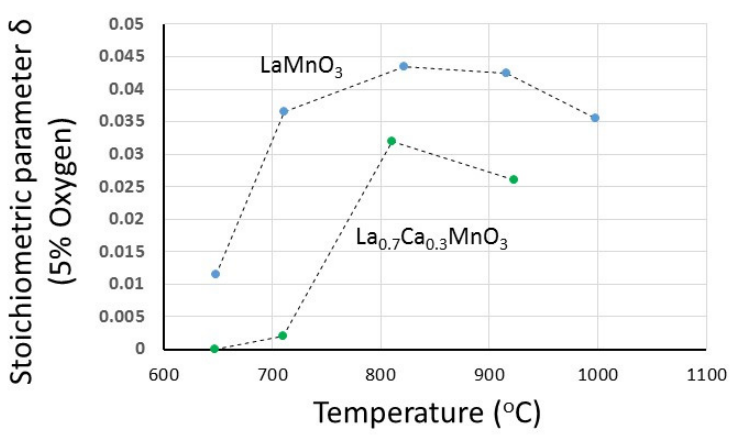
Figure 6. The dependence of oxygen excess (at 5% oxygen) on temperature for LaMnO 3 and La 0.7 Ca 0.3 MnO 3.